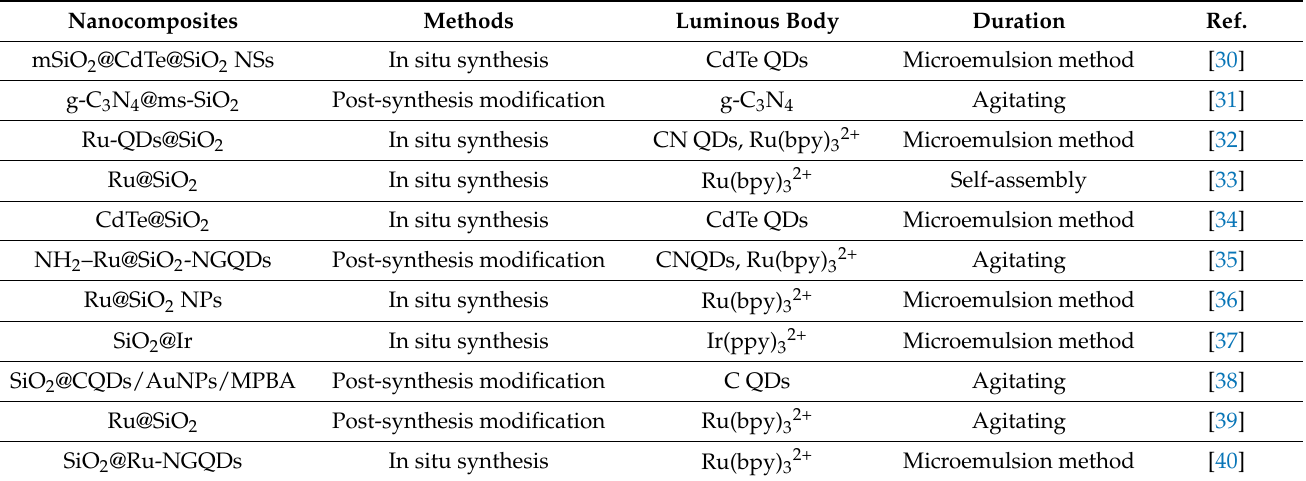
Table 1. Different synthetic strategies for OMS-based nanocomposites with ECL